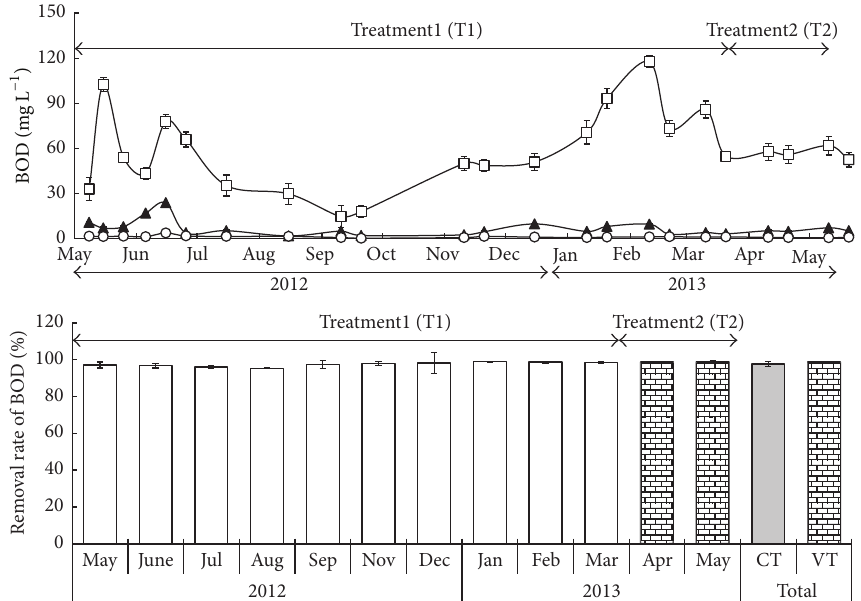
Figure 3: The concentration and removal rate of BOD in the water with time in a VF-HF hybrid constructed wetland under different ventilation methods ( ◻ : inflow; 󳵳 : 1st treatment; I : 1st + 2nd treatment; Treatment1 (T1): VF-HF CWs with natural ventilation; Treatment2 (T2): VF-HF CWs with ventilation using an electric air fan